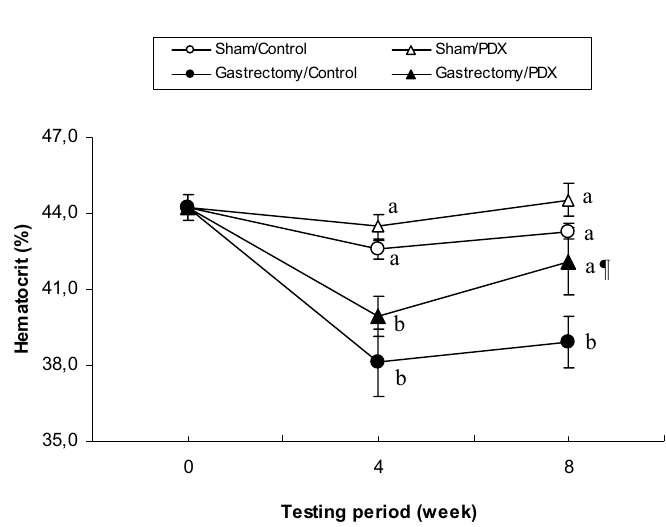
FIGURE 1 - Hematocrit concentration in sham operated or with gastrectomy rats fed diets with polydextrose (PDX) or without polydextrose (control), at 0, 4 and 8 wk after the start of the feeding period. Each values represents the means ± SEM (Sham/Control: n= 10; Sham/PDX: n=10; Gastrectomy/Control: n=9; Gastrectomy/PDX: n=9). All ANOVA main effects (treatment, diet and time) were significant. Diet (control or PDX) treatment (with or without gastrectomy) and time (0, 4, 8 wk) significantly larger than in gastrectomy control (without polydextrose). Point not sharing a common superscript are significantly different, p<0.05 (Duncan‘s multiple range test)